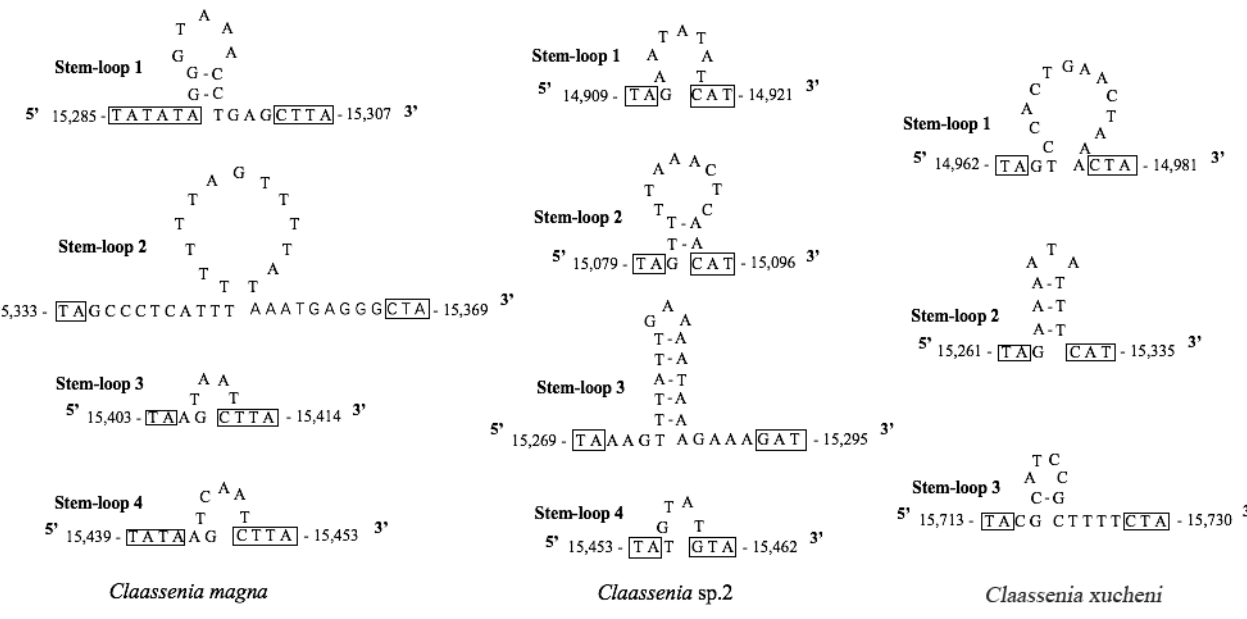
Figure 4. The potential stem-loop structures in the control region of three Claassenia species. The bilateral nucleotide motifs of each stem-loop structure [(TA) n , CAT, C(T) n A, GTA] are indicated by rectangles.